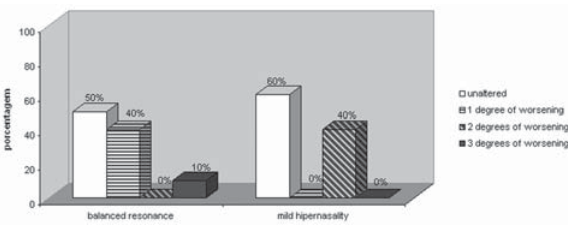
FIGURE 4- Patient distribution with balanced resonance and with mild hypernasality with regard to post-surgical resonance modification